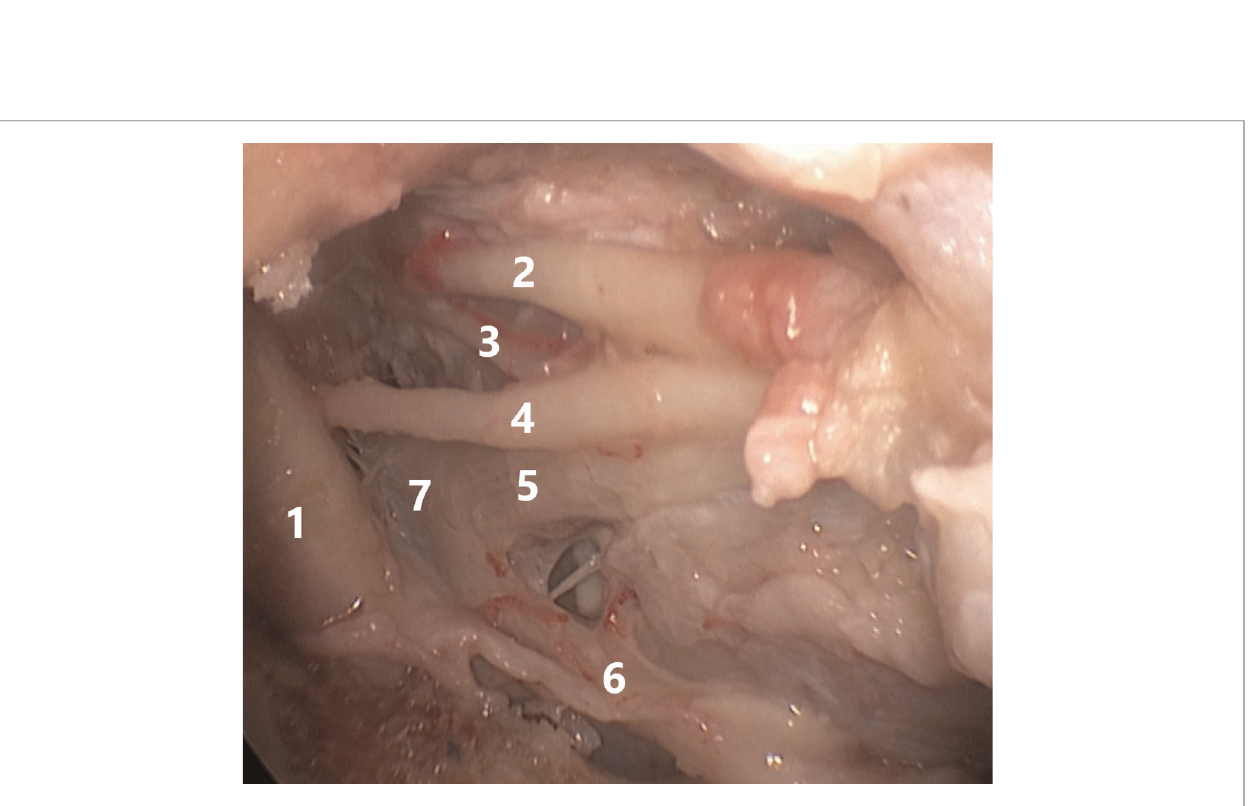
Frontiers in Surgery |